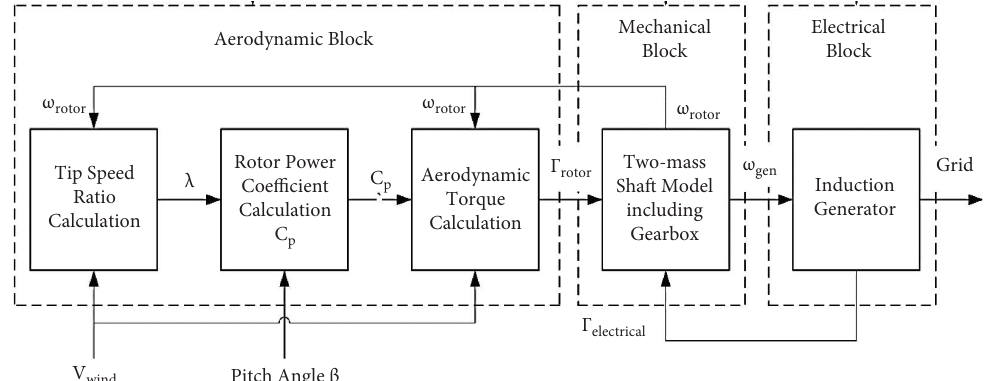
Figure 3: Wind turbine block model.